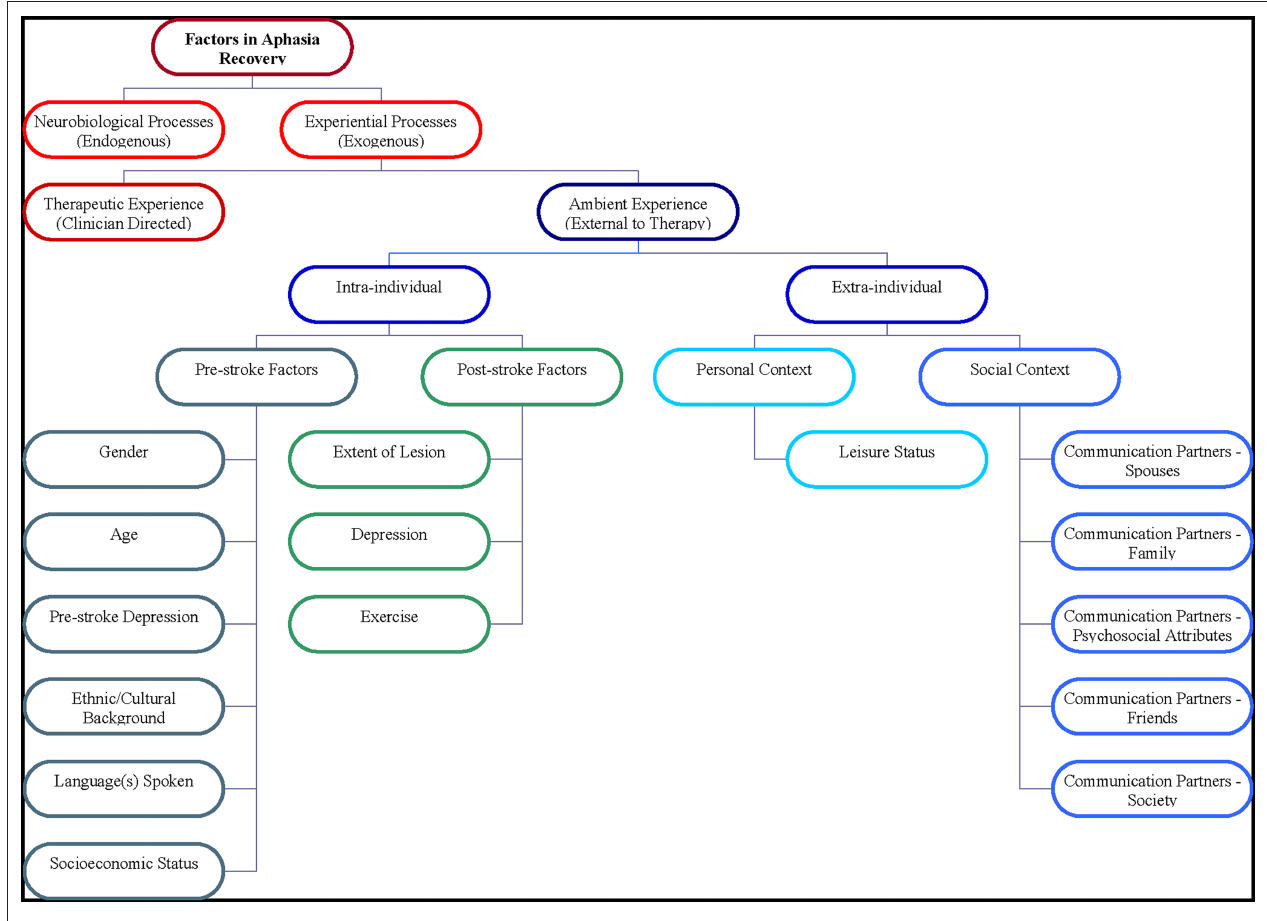
Figure 1 | Components of neurorehabilitation in aphasia